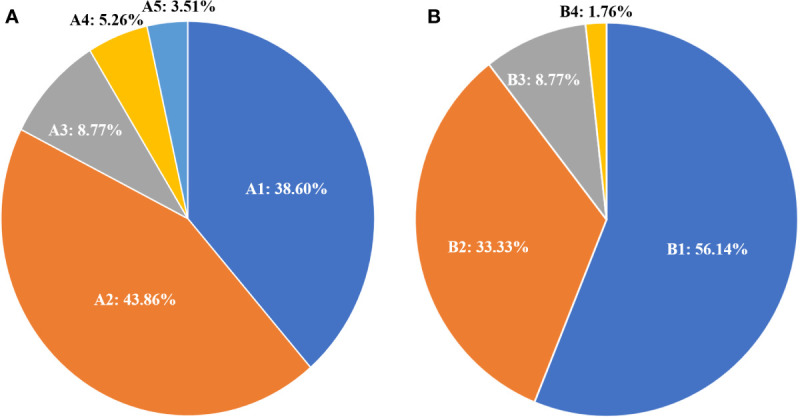
Distribution and percentage of 131I treatment status according to the RR-DTC evaluation criteria (A); A1: non-RR-WDTC; A2: identified by Criterion I; A3: by Criterion IV; A4: by Criterion II; and A5: by Criterion III. Distribution and percentage of causes of death for these patients (B); B1: patients alive at the last follow-up; B2: patients who died of distant metastases; B3: patients who died of other reasons; B4: the patient who died of locally invasive disease.